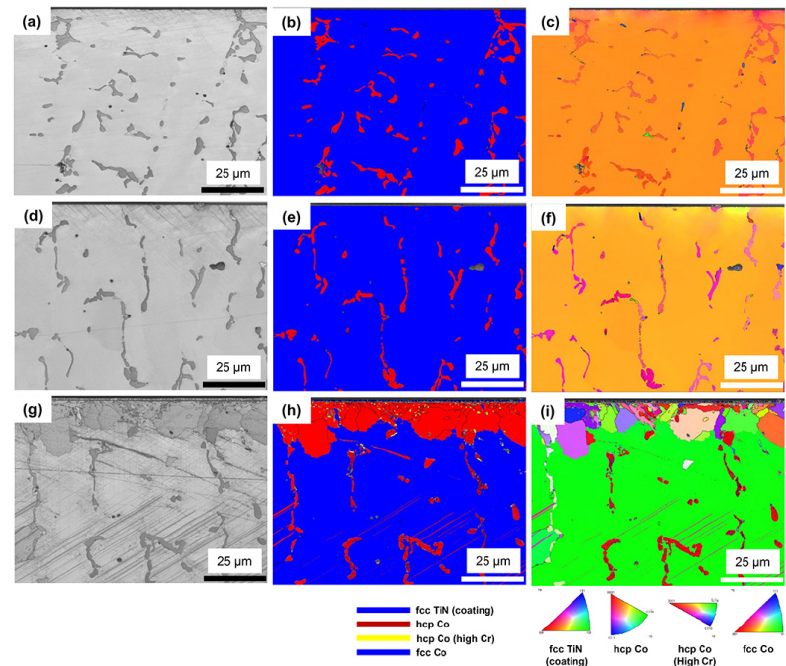
Figure 8. Cross-sectional electron backscattered di ff raction (EBSD) images of the as-cast ( a – c ), PVD-coated ( d – f ), and CVD-coated ( g – i ) Co–Cr alloys: ( a , d , g ) band contrast (BC) maps; ( b , e , h ) phase maps; and ( c , f , i ) inverse pole figure (IPF) maps.